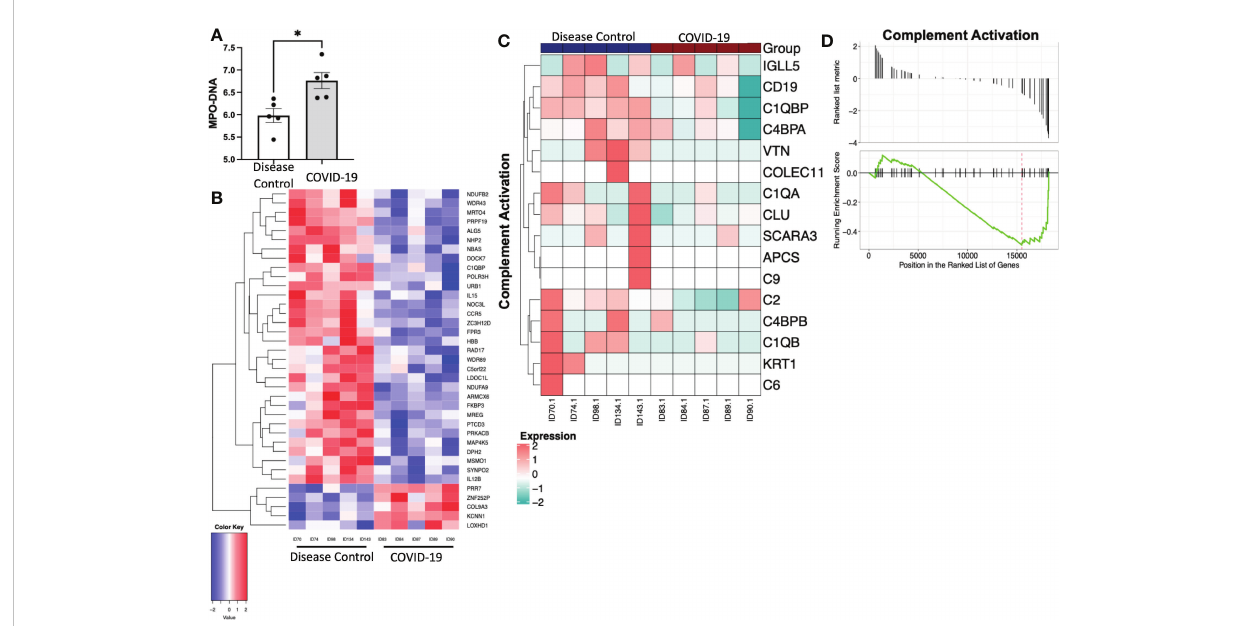
FIGURE 4 Treatment of healthy neutrophils with platelet releasate from COVID-19 patients and disease controls. (A) Myeloperoxidase-deoxy ribonucleic acid (MPO-DNA) complexes were quanti fi ed from COVID-19 patient and disease control platelet releasate treated neutrophils, measured with a capture ELISA. Data presented as optical density standardized to negative control. *, p<0.05. (B) Heatmap with hierarchical clustering displaying transcriptomic changes between treatment with platelet releasate from COVID-19 patients and disease controls. Bulk RNA sequencing results of gene changes requiring a fold change >2 and p-value <.05. There are 5 upregulated genes and 32 downregulated genes. N = 5. (C) Heatmap and (D) plot displaying the gene set enrichment pathway analysis of complement activation (Enrichment score=-0.493, p=0.038). N =